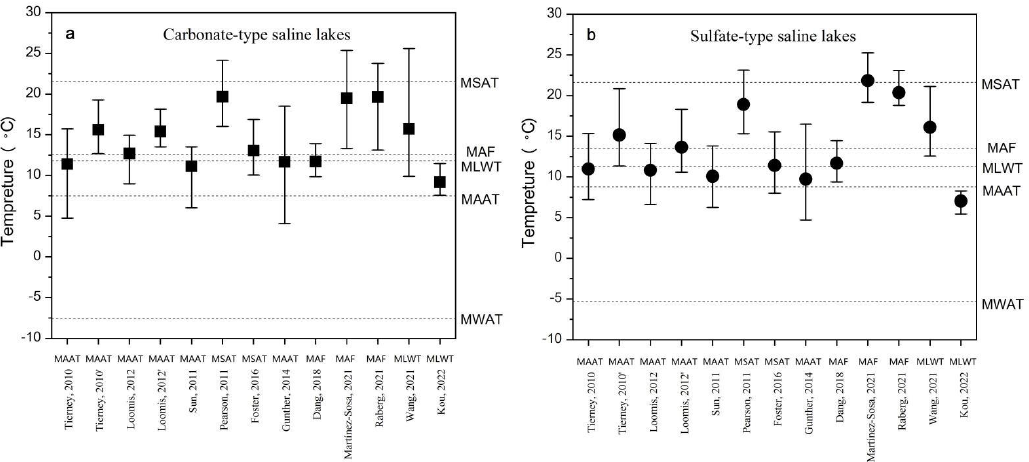
Figure 10. Comparison of reconstructed temperatures based on lake calibrations for different types of lakes as listed from formulas 20 to 32 in Table